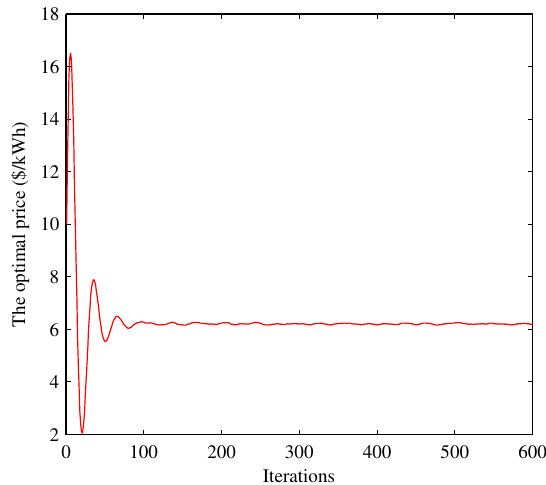
Figure 8. Convergence of the retail price under case I.